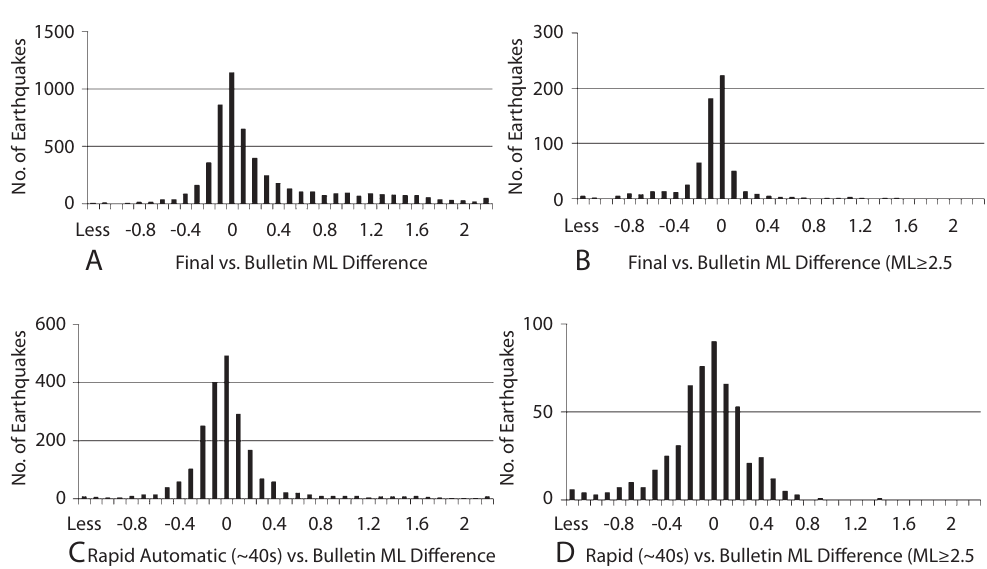
Fig. 8a-d. Comparison between automatic and bulletin magnitudes (ML) for year 2006. (a) Final automatic vs. bulletin, all earthquakes; (b) as in (a) for events with ML ≥ 2.5; (c) Rapid (~40seconds) vs. bulletin, all earth- quakes; (d) as in (c) for events with ML ≥ 2.5. Note the different scales of the Y